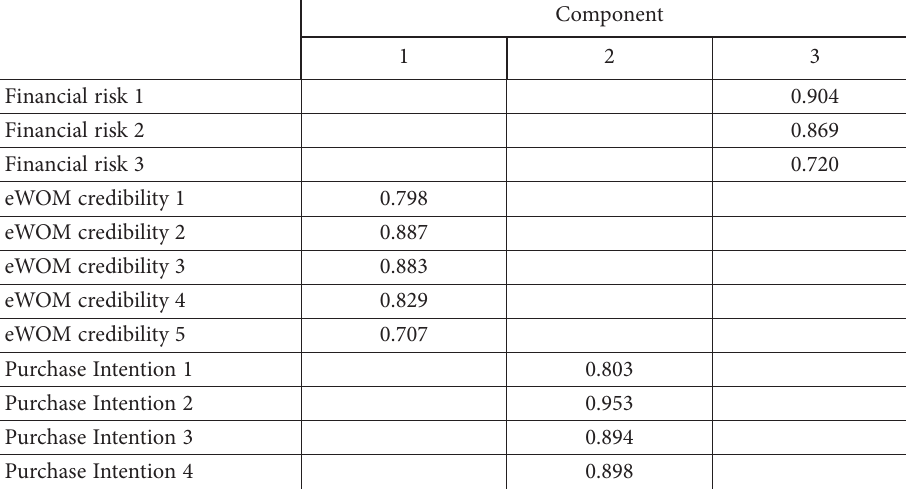
Table 3. Factor analysis results for financial risk-based neWOM perception